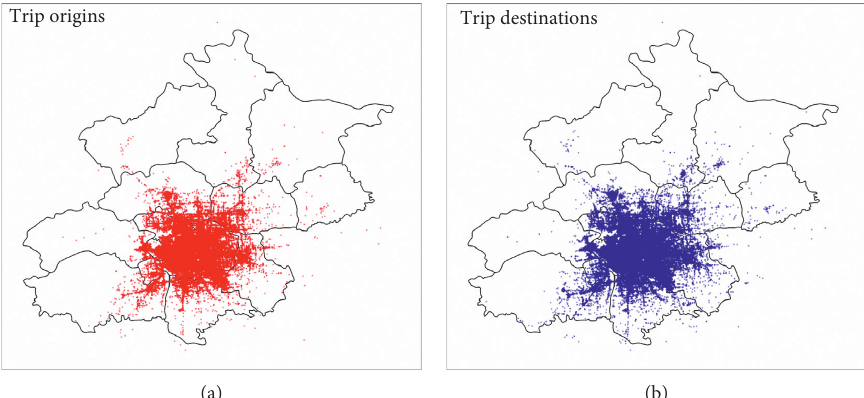
Figure 1: Spatial distributions of the origin and destination points of the taxi trips.